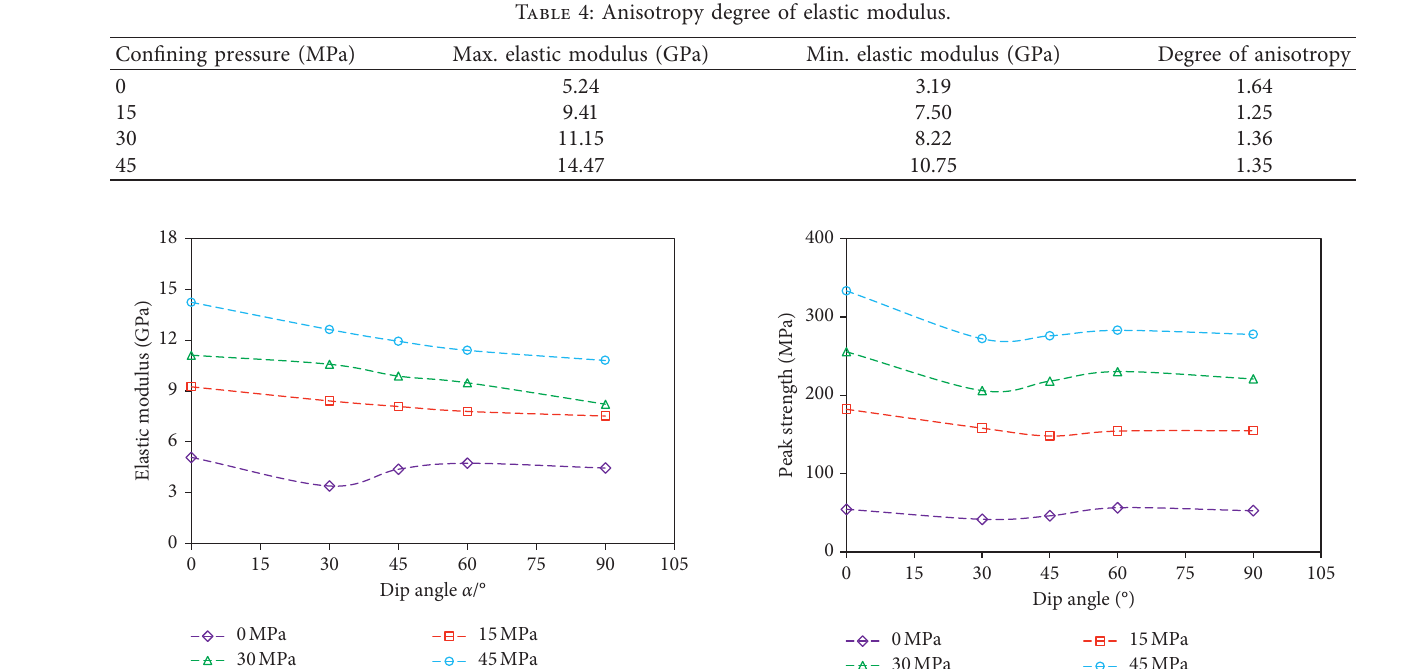
Figure 6: Elastic modulus anisotropy of the tight sandstone samples with different dip angles when subjected to different confining pressure.